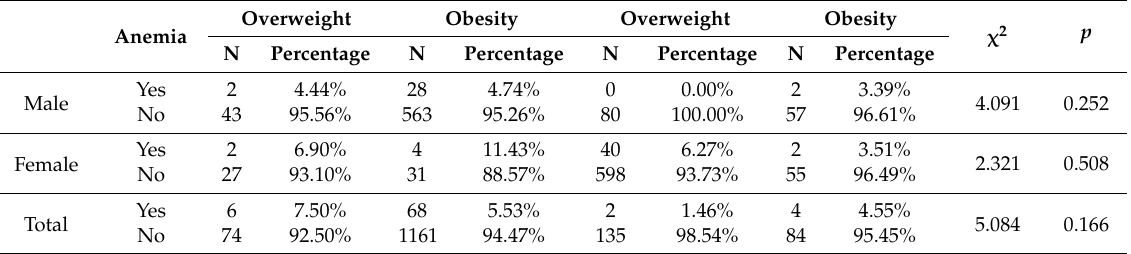
Table 4. The prevalence of anemia stratified by gender and BMI in Zhejiang province.